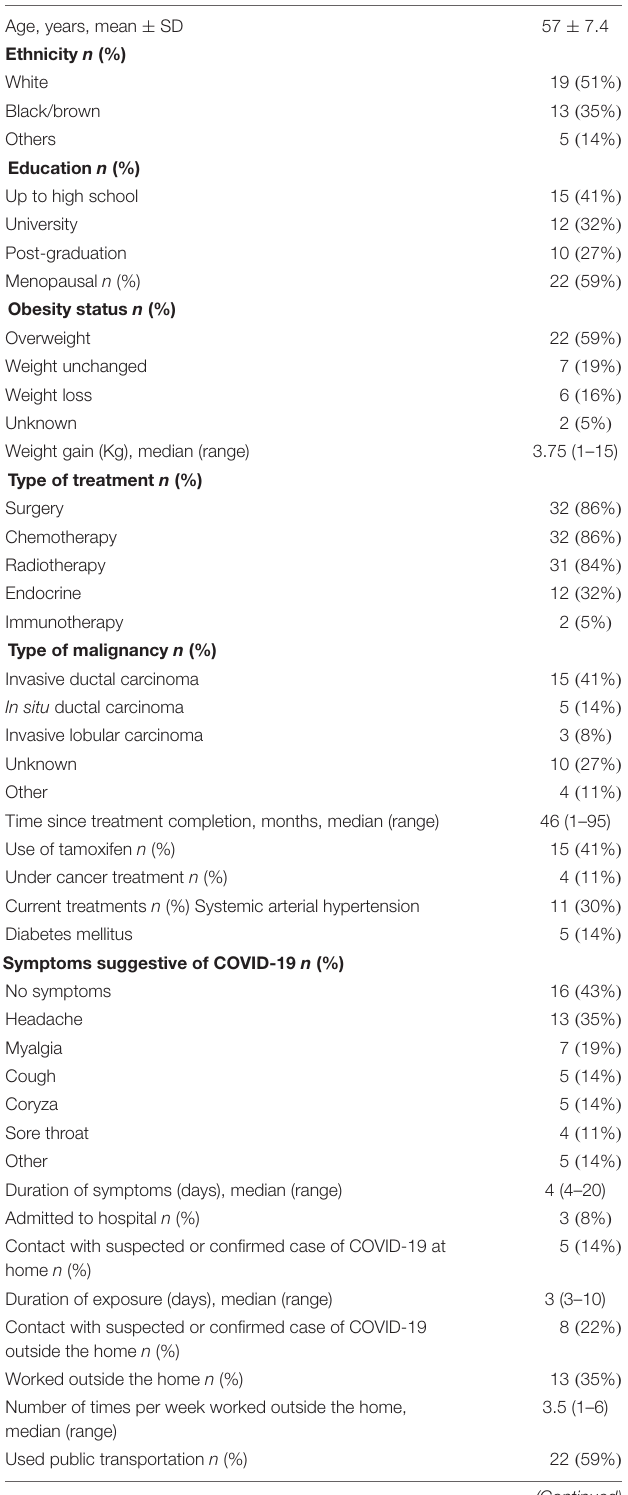
TABLE 1 | Demographic and clinical characteristics, and responses of 37 breast cancer survivors, enrolled in a program for physical activity, who answered a survey on their level of activity and perceptions on the subject, on possible COVID-19 symptoms, and on potential exposure to the disease during the